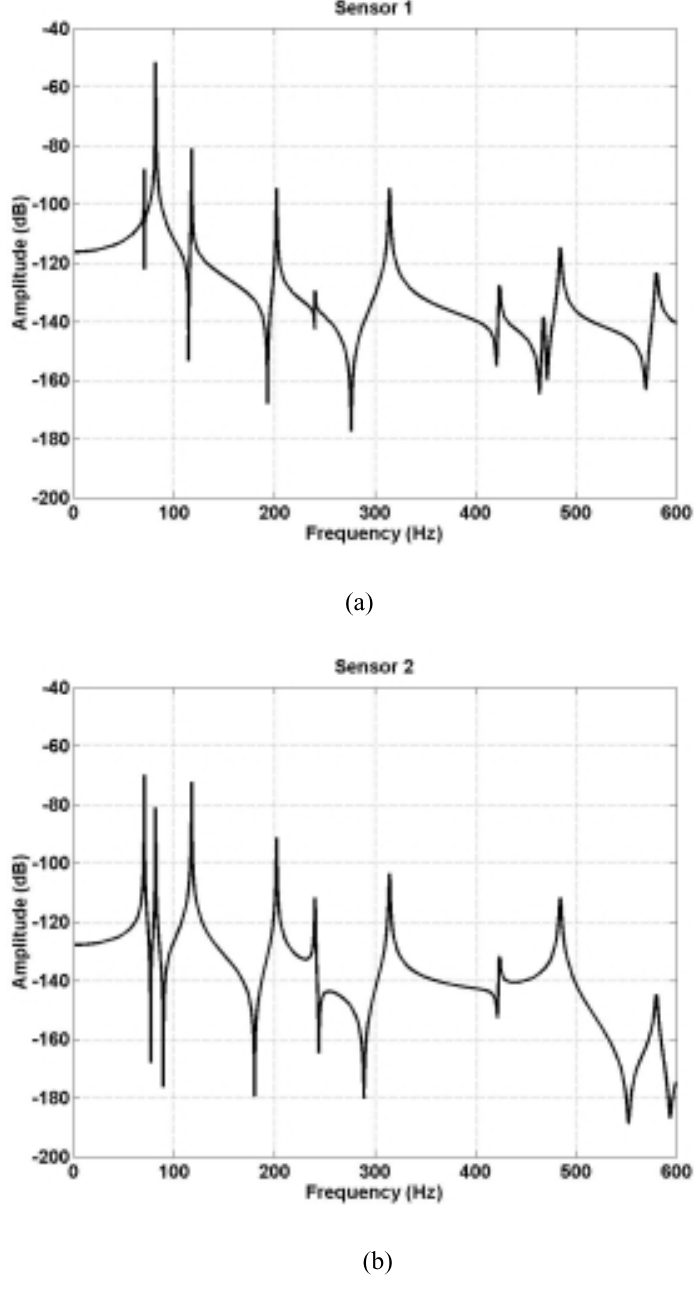
Fig. 4. Spectra of the uncontrolled response for (a) sensor 1 and (b) sensor